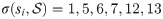
The procedure of Fair2 (Algorithm 5) when budgets are 1:2:3 and σ(si,S)=1,5,6,7,12,13 for i = 1, 2, …, 6.